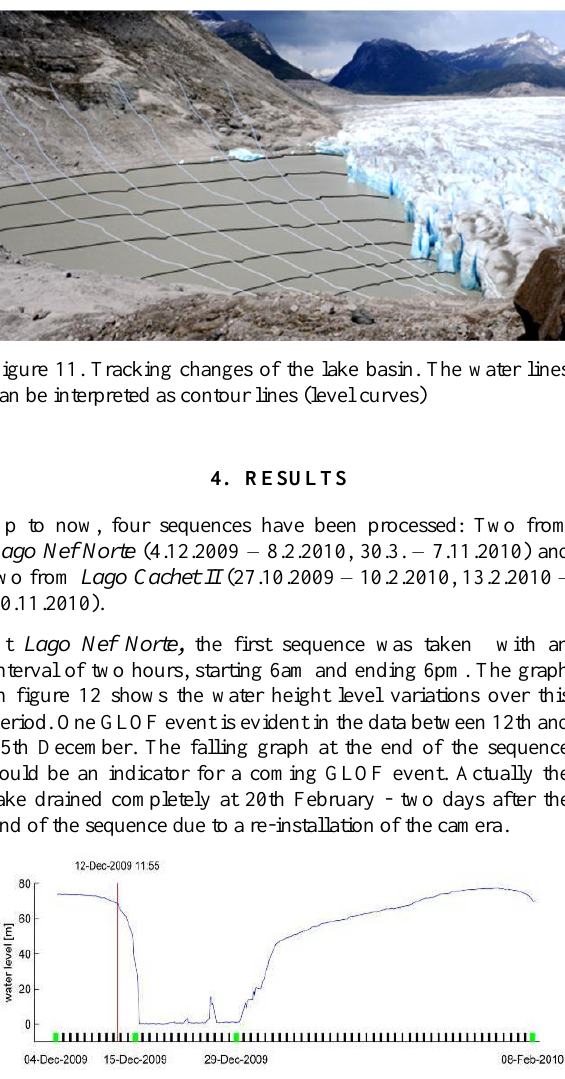
Figure 12. Water level variations at Lago Nef Norte between 4.12.2009 and 8.2.2010